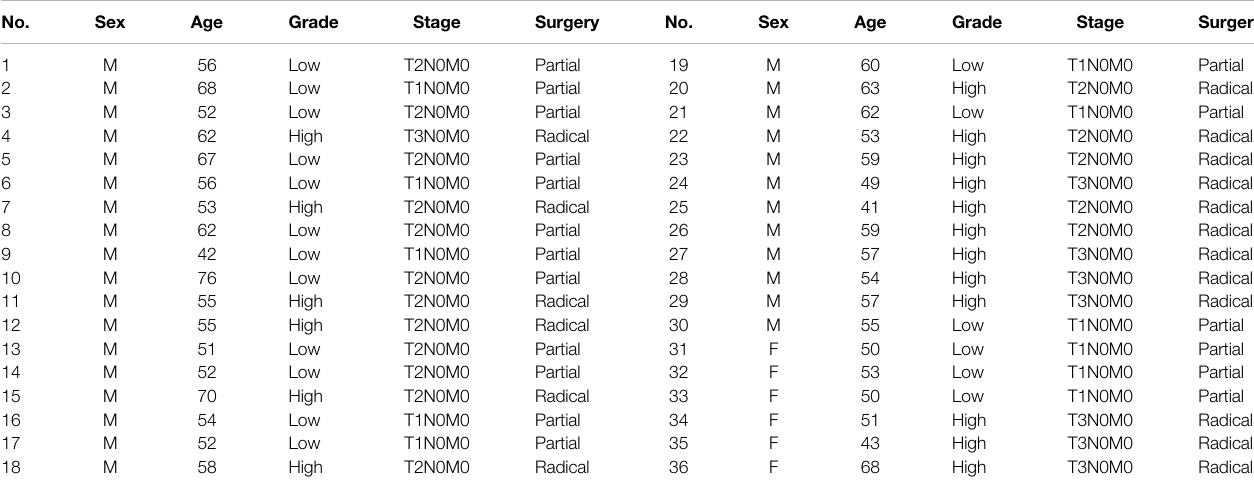
TABLE 1 | Clinical characteristics of patients with bladder cancer.